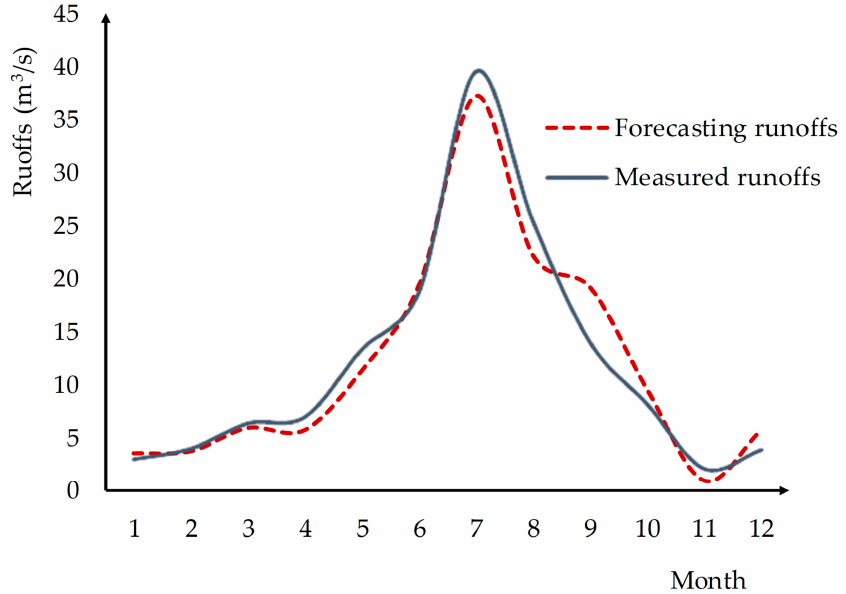
Figure 3. Comparison of forecasted runoff results and measured values.